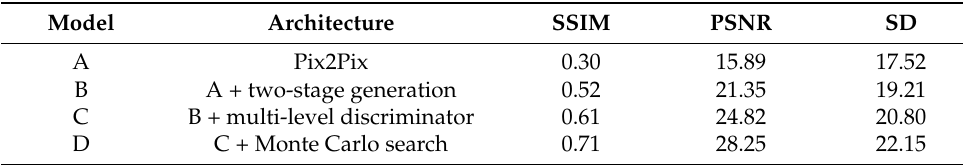
Table 11. The results of the ablation analysis.